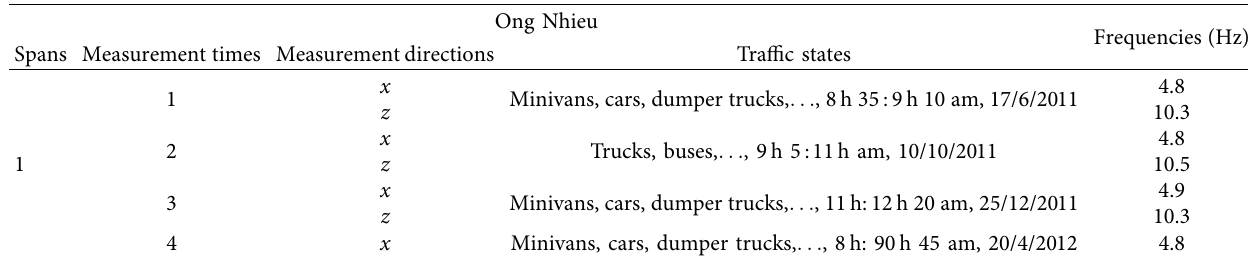
Table 10: Natural frequencies of Ong Nhieu